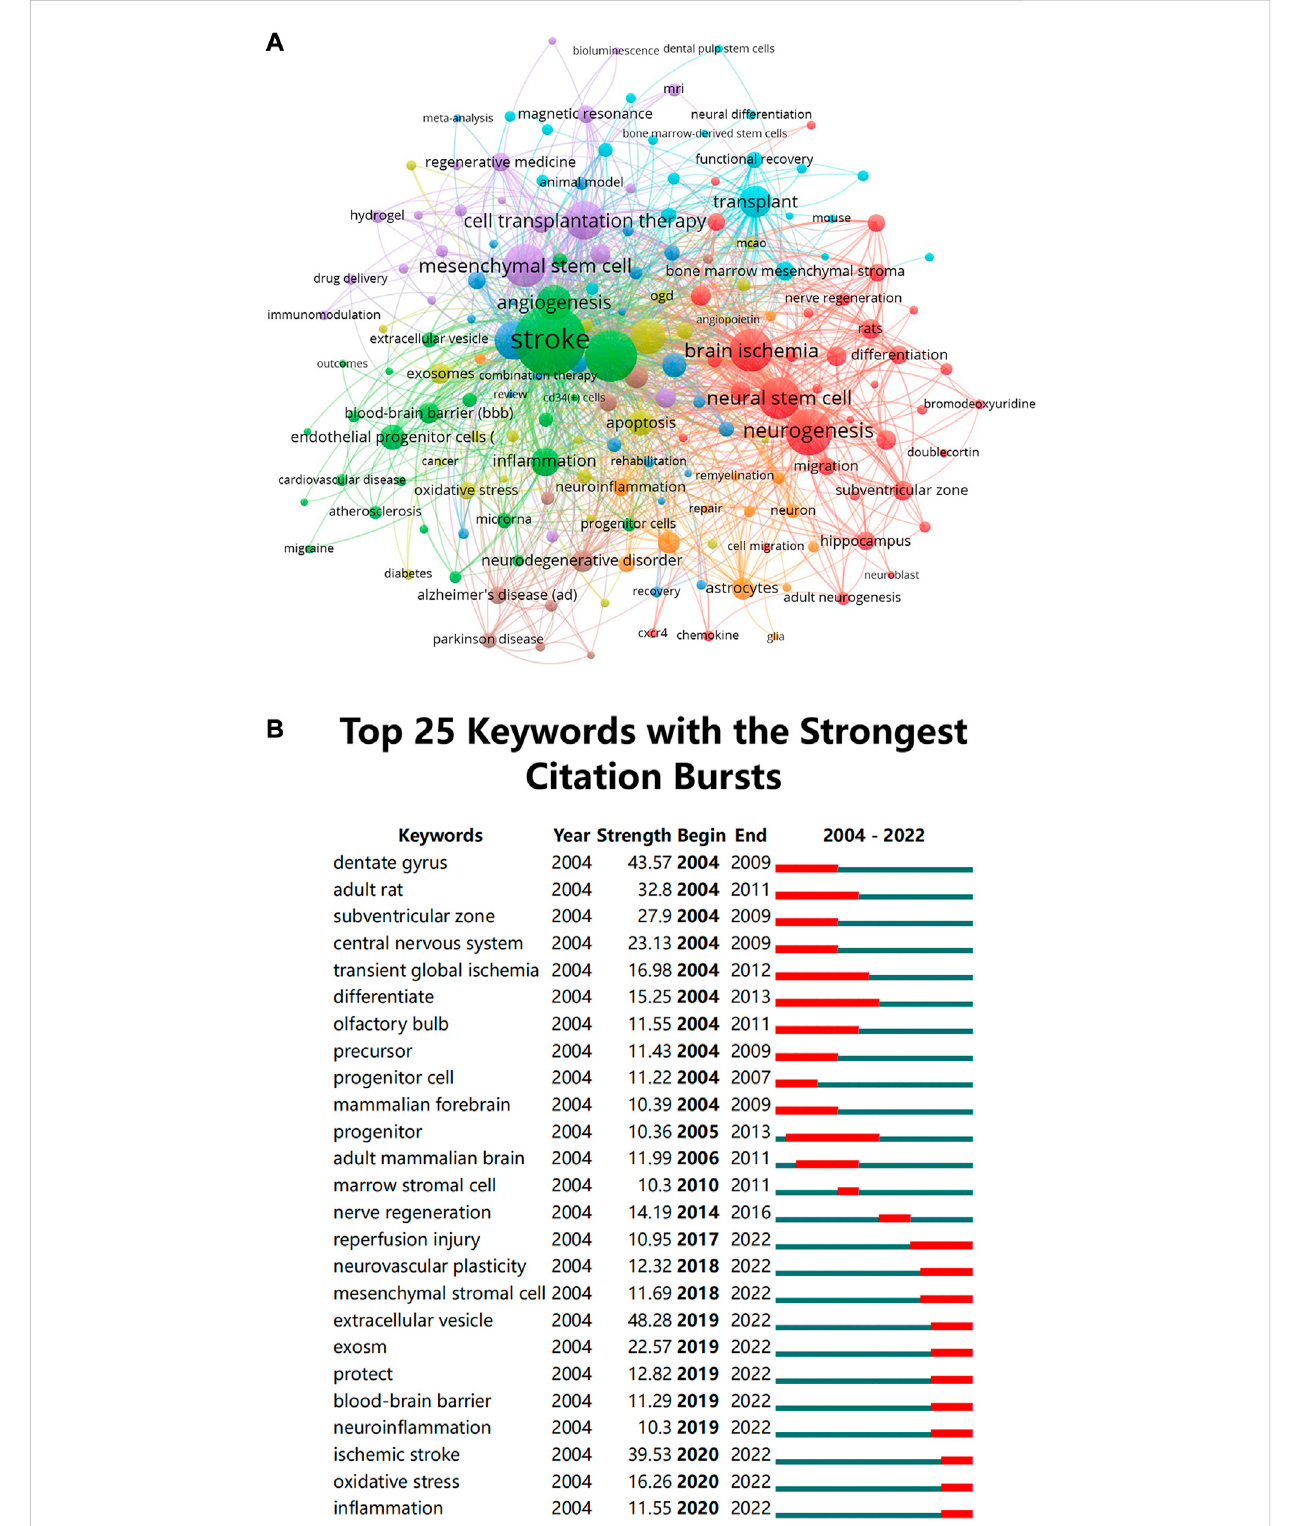
FIGURE 8 (A) Clustering of co-occurrence among keywords. The circles and labels in the fi gure constitute a unit, and the units of different colors constitute different clusters (B) CiteSpace visualization map of top 25 keywords with the strongest citation bursts involved in stem cells in